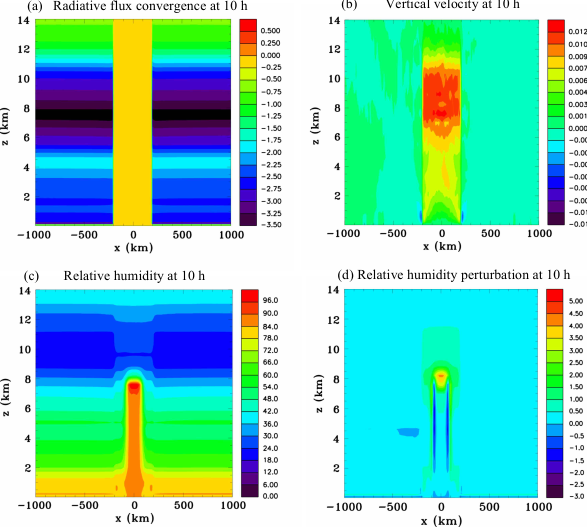
Figure 16. Vertical sections for Experiment 11: the radiation scheme activated in the whole domain with a mid-level vortex case. (a) Potential temperature perturbation (K), (b) vertical veloc- ity (ms − 1 ), (c) relative humidity, and (d) y -component of velocity, v (ms − 1 ), at t = 24h, in mid-morning.